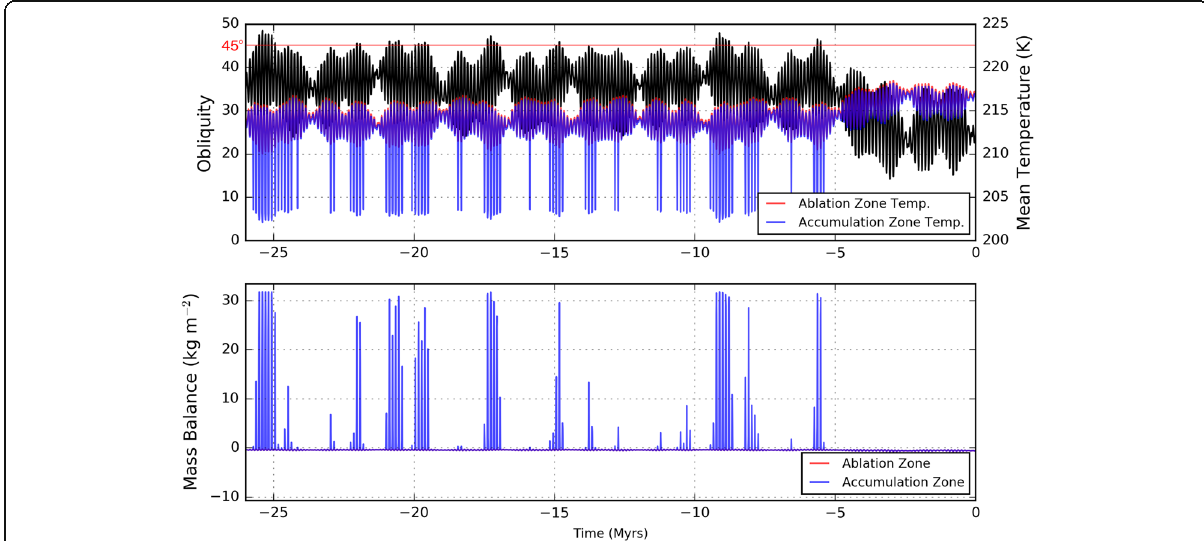
Fig. 9 Obliquity and associated temperature and mass balance model inputs for the past 26 Myr. a Obliquity (black line) determined by Laskar et al. (2004) and the average surface temperature in the accumulation (red line) and ablation zones (blue line). If ice is accumulating in the specified accumulation zone, the surface albedo in the zone is changed from 0.3 to 0.4 resulting in a ~ 10 K drop in temperature. b The ablation rate changes with local temperature (Eq. 5), and ablation occurs everywhere at obliquity less than roughly 44 ° . The rate of accumulation depends on obliquity using the assumed relationship shown in Fig.